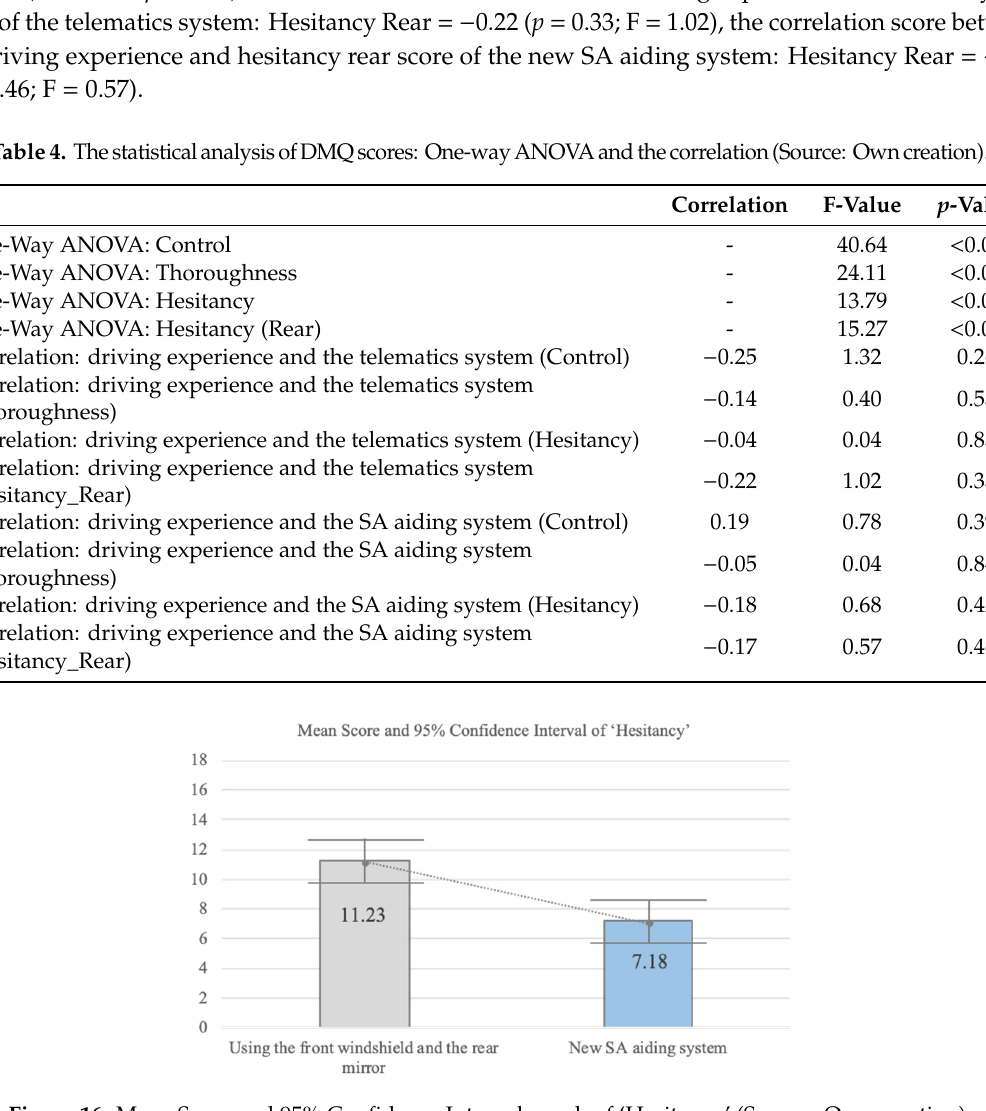
Figure 16. Mean Score and 95% Confidence Interval graph of ‘Hesitancy’ (Source: Own creation).